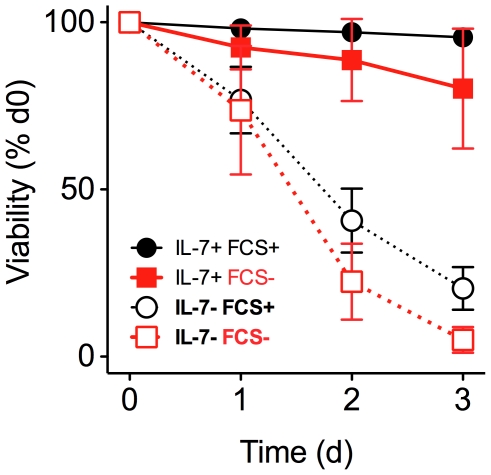
Minimal fetal calf serum requirement for IL-7 dependent survival of CD8+ T cells.CD8+ T cells were enriched from C57Bl6/J donors and cultured for the times indicated, either alone (open symbols, dashed lines), or in the presence of 50 ng/ml of IL-7 (filled symbols, solid lines) and additionally either in presence (circles) or absence (squares) of foetal calf serum (FCS). Cells were stained with 7AAD and viability amongst CD44loCD8+ cells determined by measuring the frequency of 7AAD− live cells by flow cytometry. Percentage of surviving cells was normalized to the percentage of live cells on day 0. Results are pool of three independent experiments. Error bars indicate SD of biological replicates.